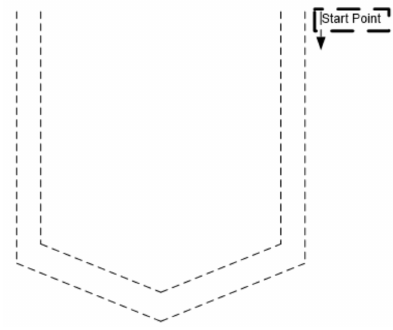
Figure 1. Skill development and retrieval assessment procedure.